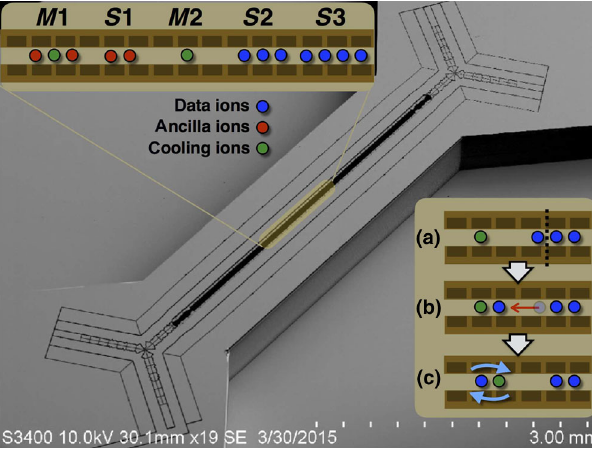
FIG. 1. The Sandia HOA2 trap as a QEC platform: In our envisioned scheme, 40 Ca þ ions (blue and red dots) are cotrapped with 88 Sr þ ions (green dots) in a quantum zone divided into three storage regions S 1 , S 2 , S 3 and two manipulations zones M 1 , M 2 . Some of the 40 Ca þ ions can be used as data qubits to encode quantum information according to a QEC code (blue dots), while others (red dots) can be used as ancilla qubits for syndrome extraction. The 88 Sr þ ions (green dots) are used as sympathetic coolants to reduce the number of phonons prior to the entangling gates. Possible crystal-reconfiguration operations are shown in the panel in the lower-right corner: (a) splitting of an ion crystal, (b) shuttling of an ion and subsequent merging with another ion to form a crystal, and (c) rotation (swapping) of a mixed species crystal. Schematics of the trap are adapted from a micrograph in Ref.